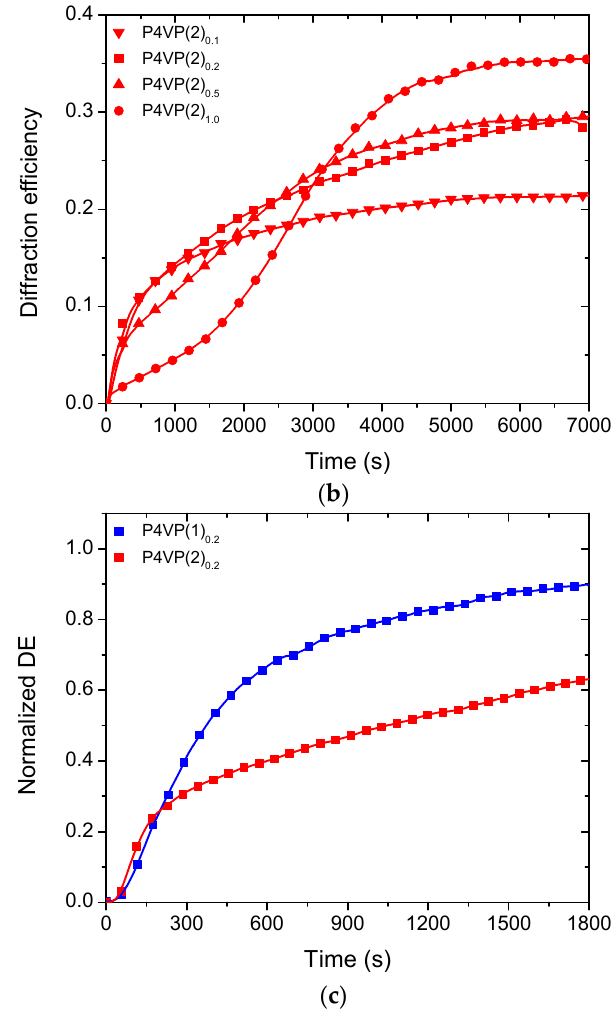
Figure 4. Development of first order diffraction efficiencies during SRG formation with a writing beam irradiation intensity of 300 mW·cm − 2 (488 nm) for ( a ) P4VP( 1 ) x and ( b ) P4VP( 2 ) x ; and ( c ) the normalized diffraction efficiencies (0–1800 s) during SRG formation for the samples with nominal complexation degree x = 0.2.